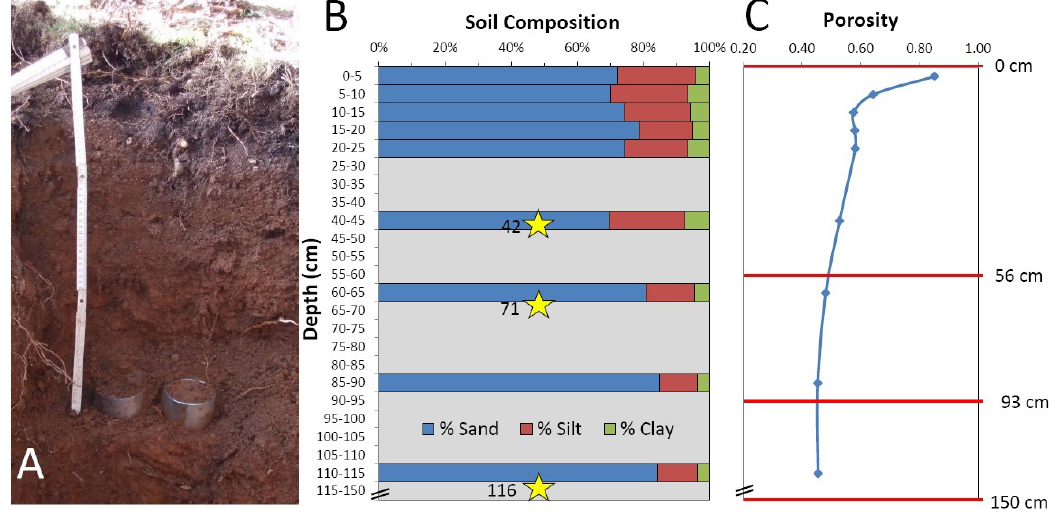
Figure 2. ( A ) Undisturbed soil cylinder samplers. ( B ) Soil composition profile; yellow stars correspond to sampling points and ( C ) porosity profile obtained through laboratory analysis of the field samples. These values are used for the ROSETTA pedotransfer function. The red lines in ( C ) represent the interfaces between the three layers of the adopted soil